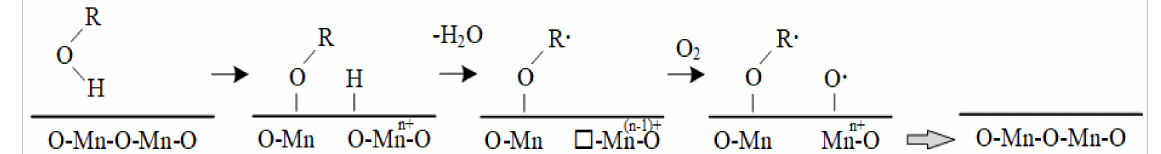
Figure 2. Diagram of catalytic mechanism of manganese